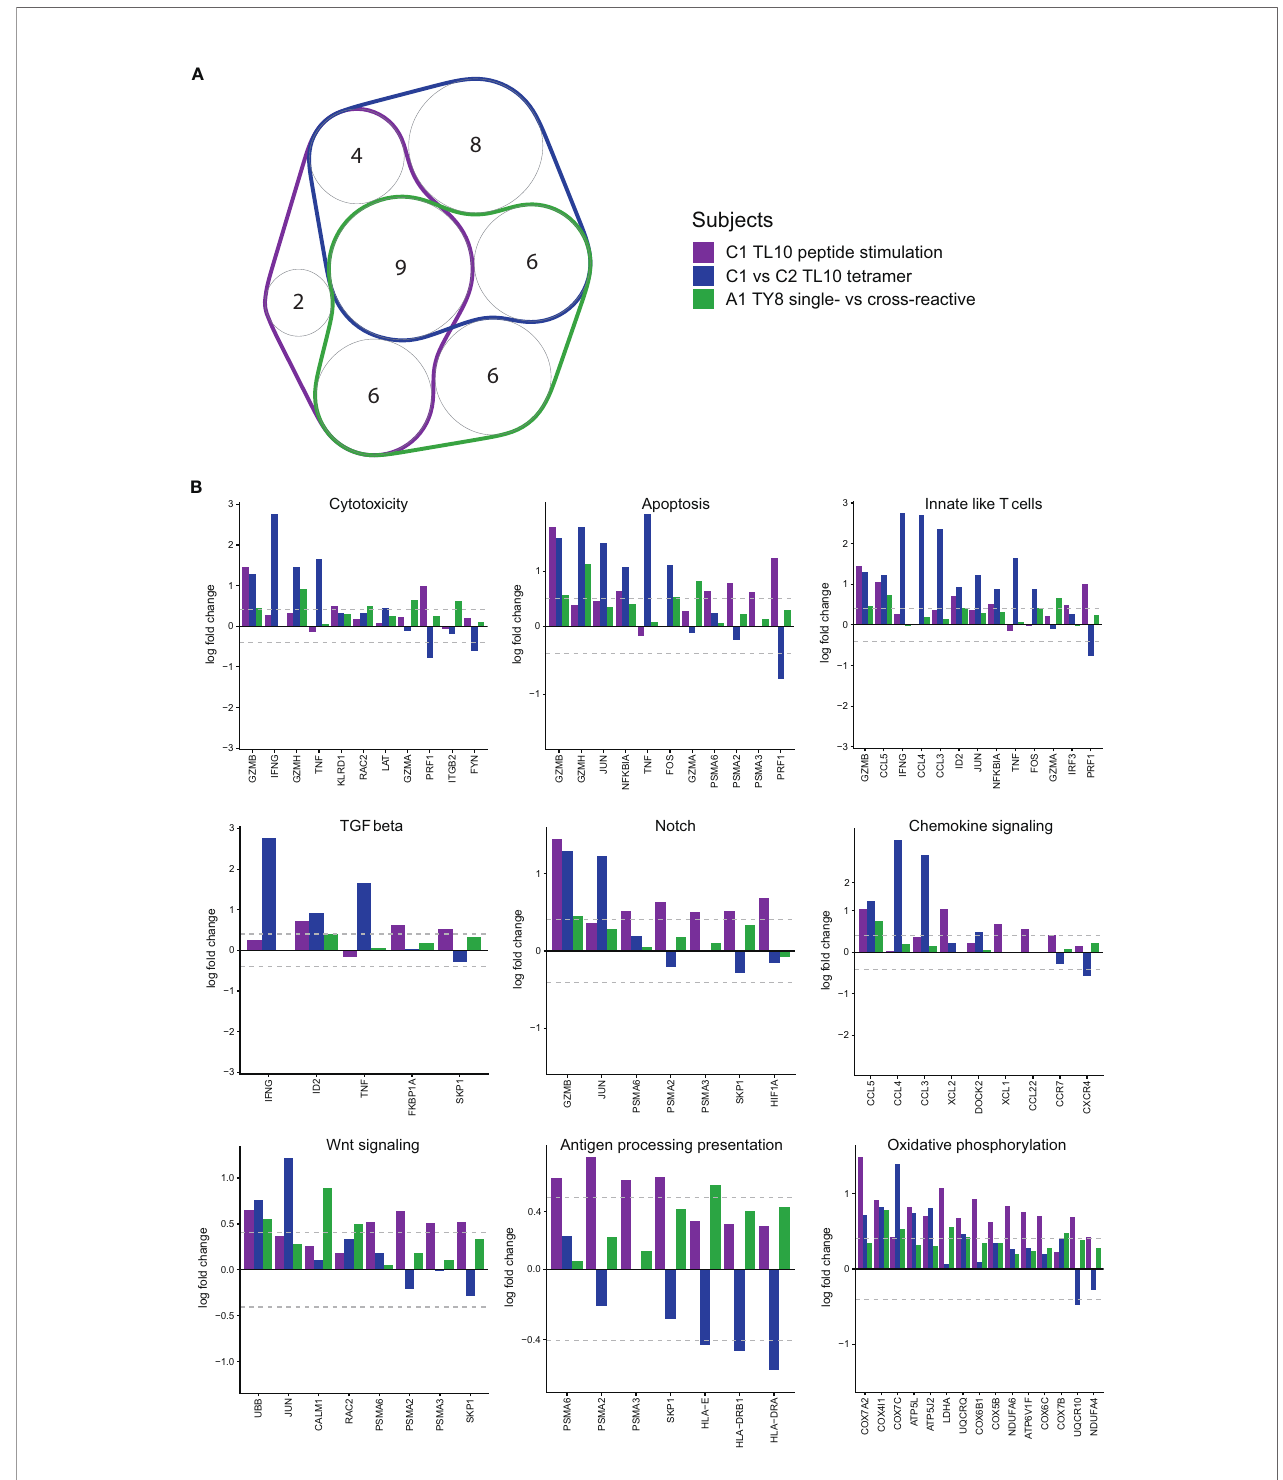
FIGURE 6 | Pathway analyses reveal common upregulated pathways and genes in antigen-speci fi c CD8 + T cells likely exhibiting an ‘ effective ’ immune response. GSVA pathway scores were used to measure cell expression of genes in speci fi c pathways (Nanostring CAR-T). (A) A number of pathways with a signi fi cant difference (p<0.05; Kruskal-Wallis) were common in the different conditions (N = 3). Only pathways with three or more genes were taken through for further analysis (memory markers and TCR diversity were excluded). (B) The nine pathways that were common to all categories were taken through to determine potential driving genes (N = 3). All conditions are shown, but only genes that have at least one signi fi cant fold change ( ≥ |1.5|) were